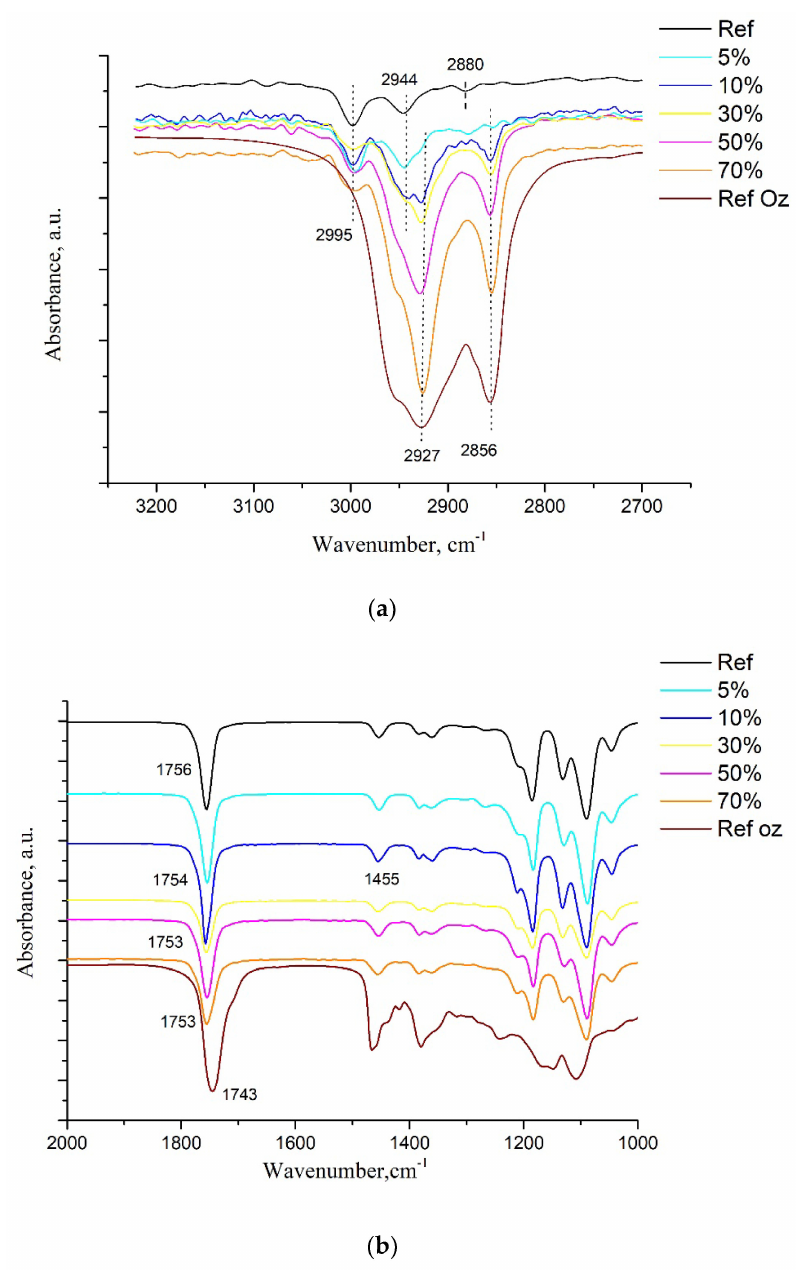
Figure 7. FTIR spectra of pristine PLA film, PLA + OTOA films and pure OTOA: ( a ) Close-up view of FTIR spectra at 2700–3000 cm − 1 interval ( a ), FTIR spectra at 900–2000 cm − 1 wavenumber region ( b